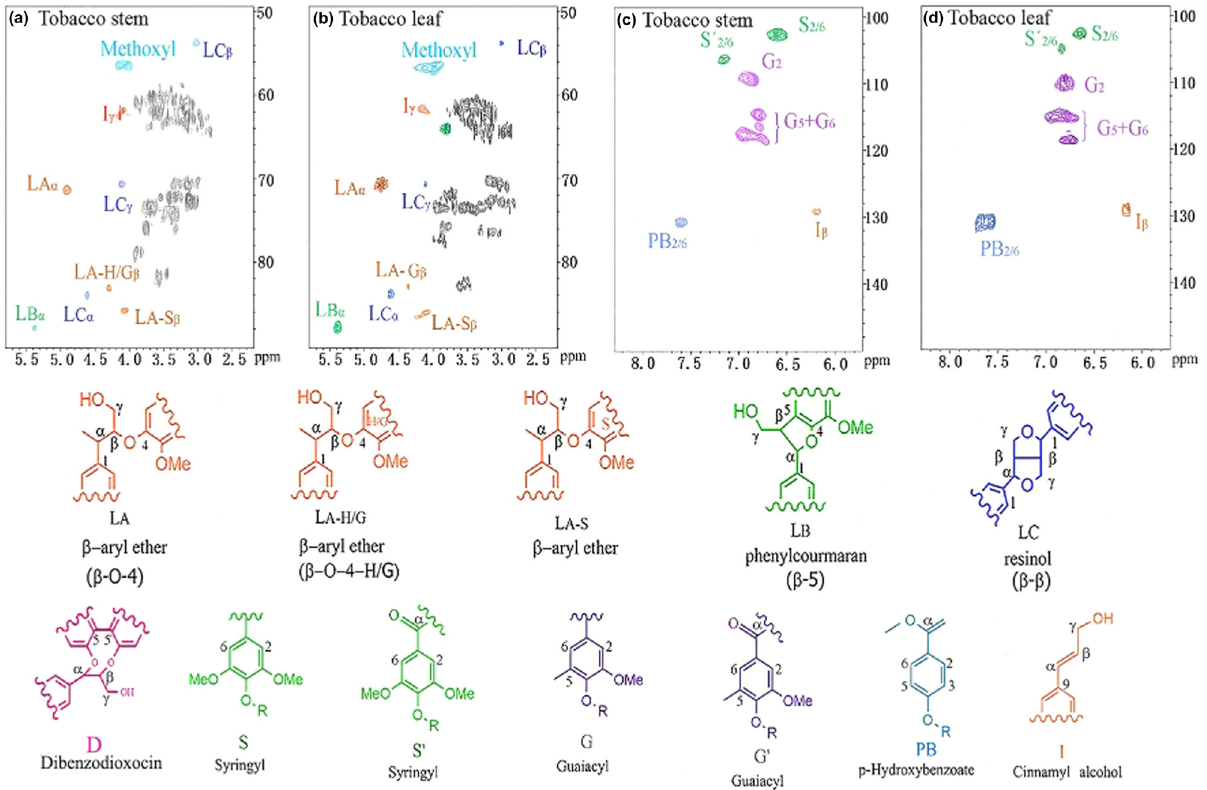
Figure 3: 2D HSQC NMR spectra of lignin side chain regions polysaccharide regions ( a and b ) and aromatic regions ( c and d ) of plant cell walls in DMSO - d 6 /HMPA - d 18